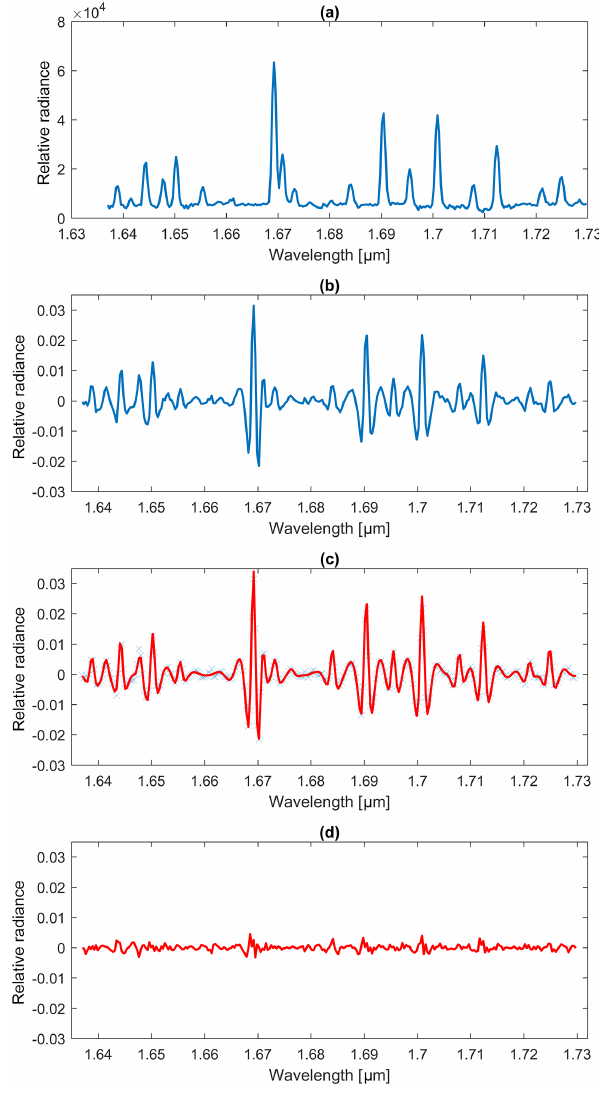
Figure 3. (a) Unfiltered spectrum of the (5, 3) transition. (b) Fil- tered spectrum of the (5, 3) transition. (c) Normalized spectrum from (b) (blue crosses) with the fitted, filtered model spectrum shown in red. The fitted rotational temperature is 186.5 ±